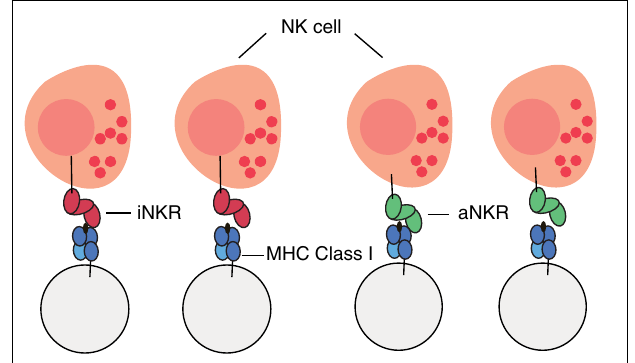
FIGURE 1 | Cartoon of NK cell education . iNKRs (represented in red) recognizing at least one of the MHC molecules per individual will become licensed. In contrast, aNKRs (depicted in green), which do not recognize any of the host’s MHC molecules will become licensed.